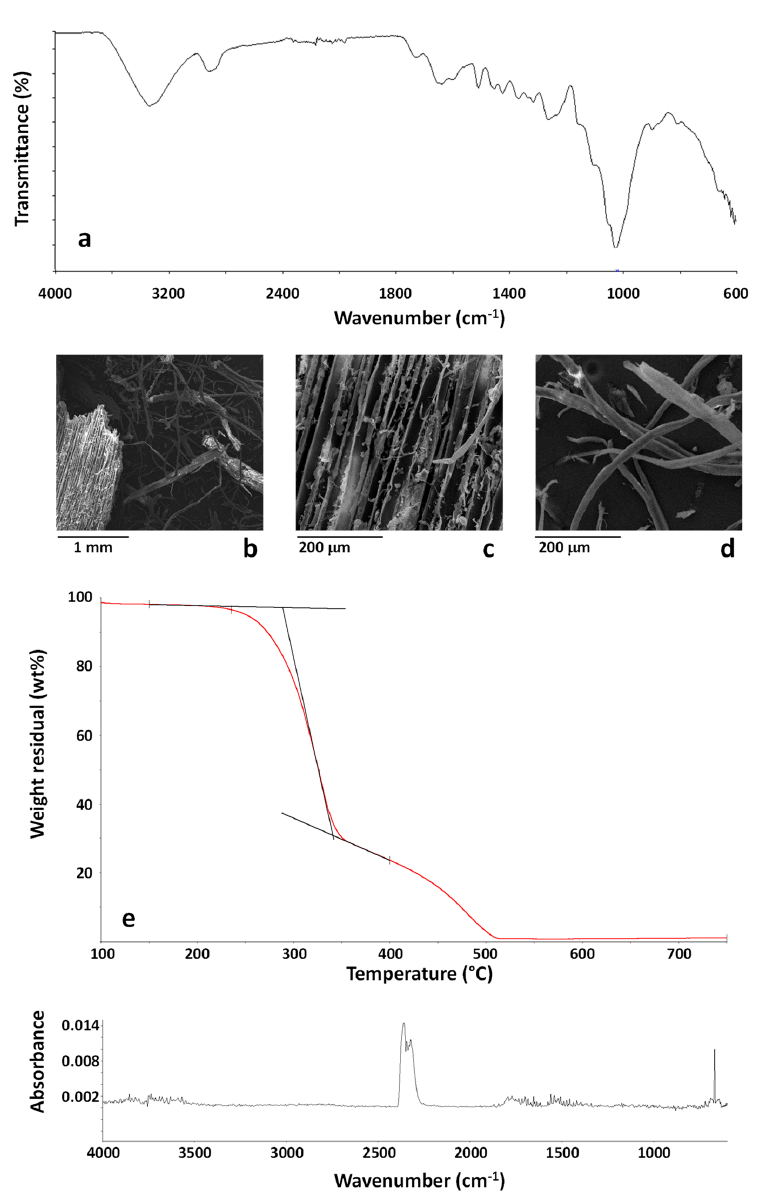
Figure 4. FTIR spectrum ( a ) and SEM images ( b – d ) of the CDW sample. TG curve of the sample CDW in the temperature range 100–750 ◦ C ( e ). FTIR spectrum of the evolved gases from the sample CDW at 260 ◦ C during TG experiment ( f